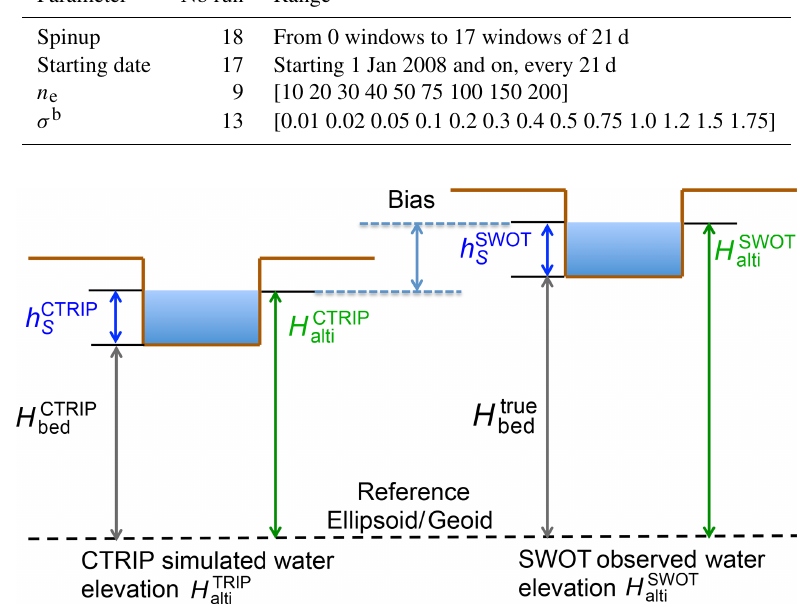
Figure 4. Illustration of a bias case between the water elevation as observed by SWOT ( H SWOT because of a bias between model and true river beds.